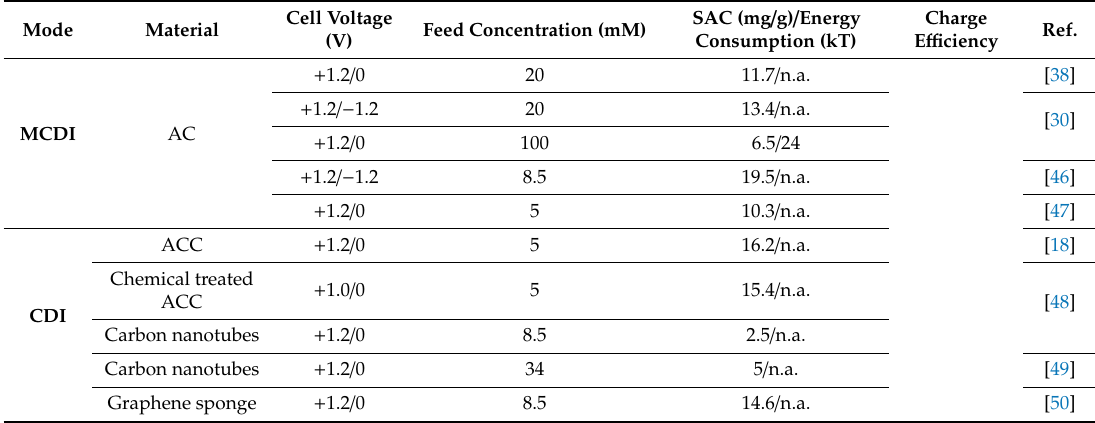
Figure 5. Basic cell architecture of multichannel membrane CDI (MC-MCDI) using channels and ion exchange membranes: ( A ) Conceptual scheme, ( B ) frame components, and ( C ) exploded view of cell assembly (Reprinted with permission from Reference [32]). Table 3. Comparison of the desalination performance such as salt adsorption capacity (SAC), energy consumption, and the charge e ffi ciency among MCDI, CDI, and MC-MCDI. AC represents activated carbon material, and ACC represents activated carbon